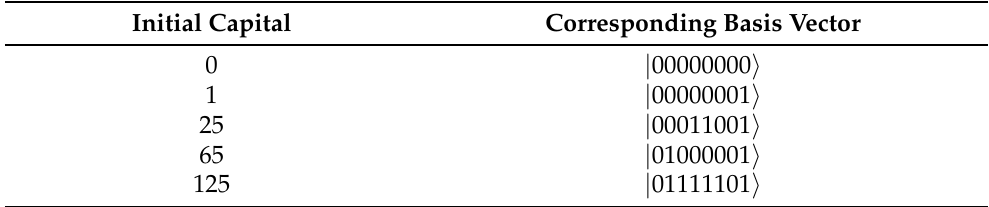
Table 6. Initial capitals and corresponding basis vectors for 8 qubits.